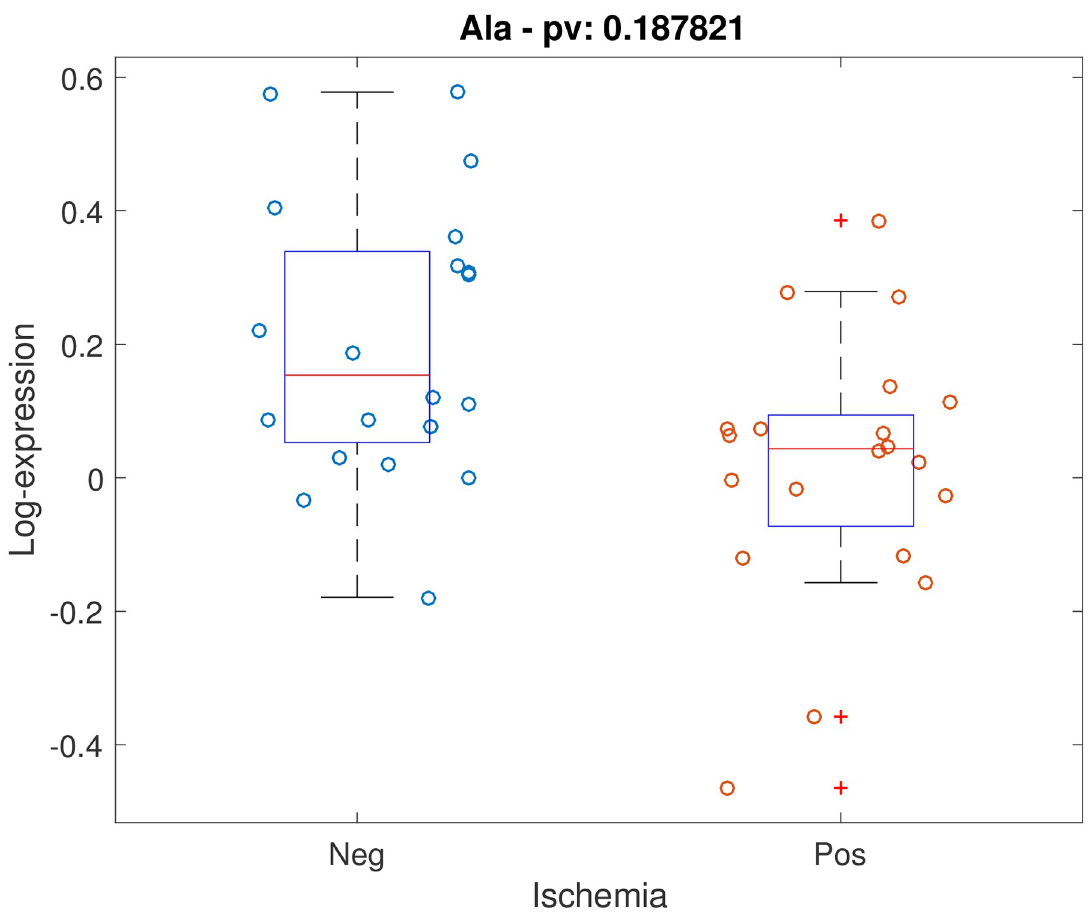
Fig 1. Scatter plot of stress-delta in alanine for patients who were positive versus negative for ischemia. When assessing changes in metabolite levels across timepoints while controlling for age, gender and BMI, 5 metabolites had FDR < 0.2: alanine, C14:1-OH, C16:1, C18:2,